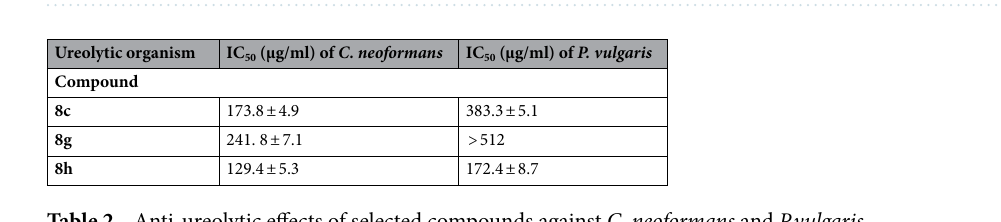
Table 2. Anti-ureolytic effects of selected compounds against C. neoformans and P.vulgaris.